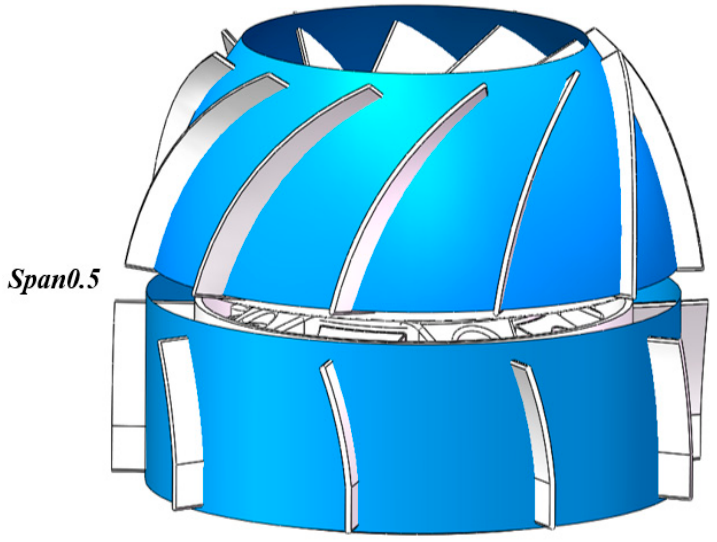
Figure 19. A leaf expansion diagram.